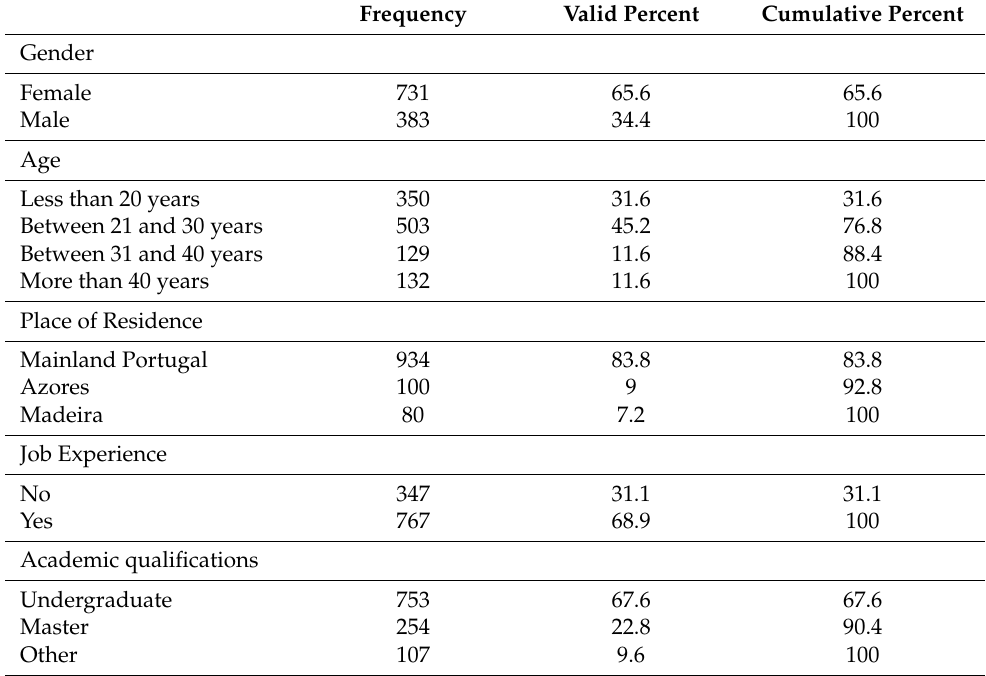
Table 1. Statistics of sociodemographic